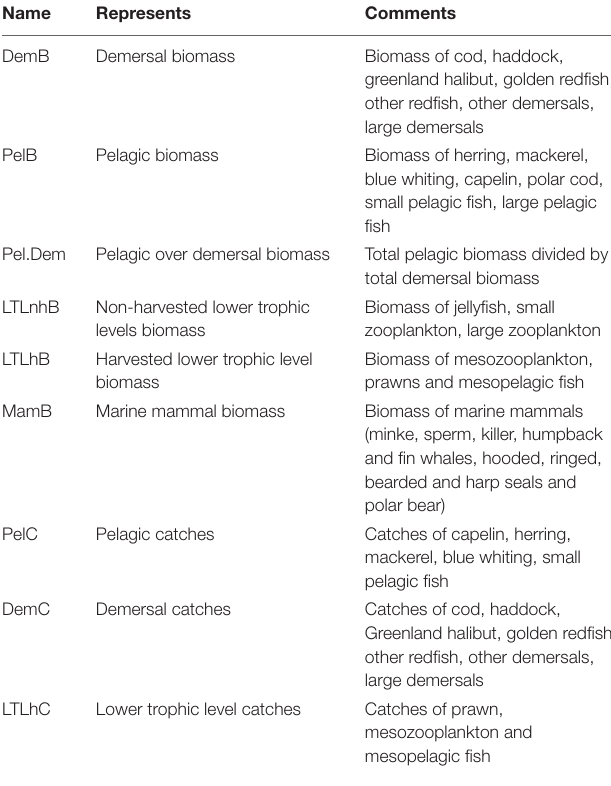
TABLE 2 | Ecological indicators, explanation and abbreviations used in figures and